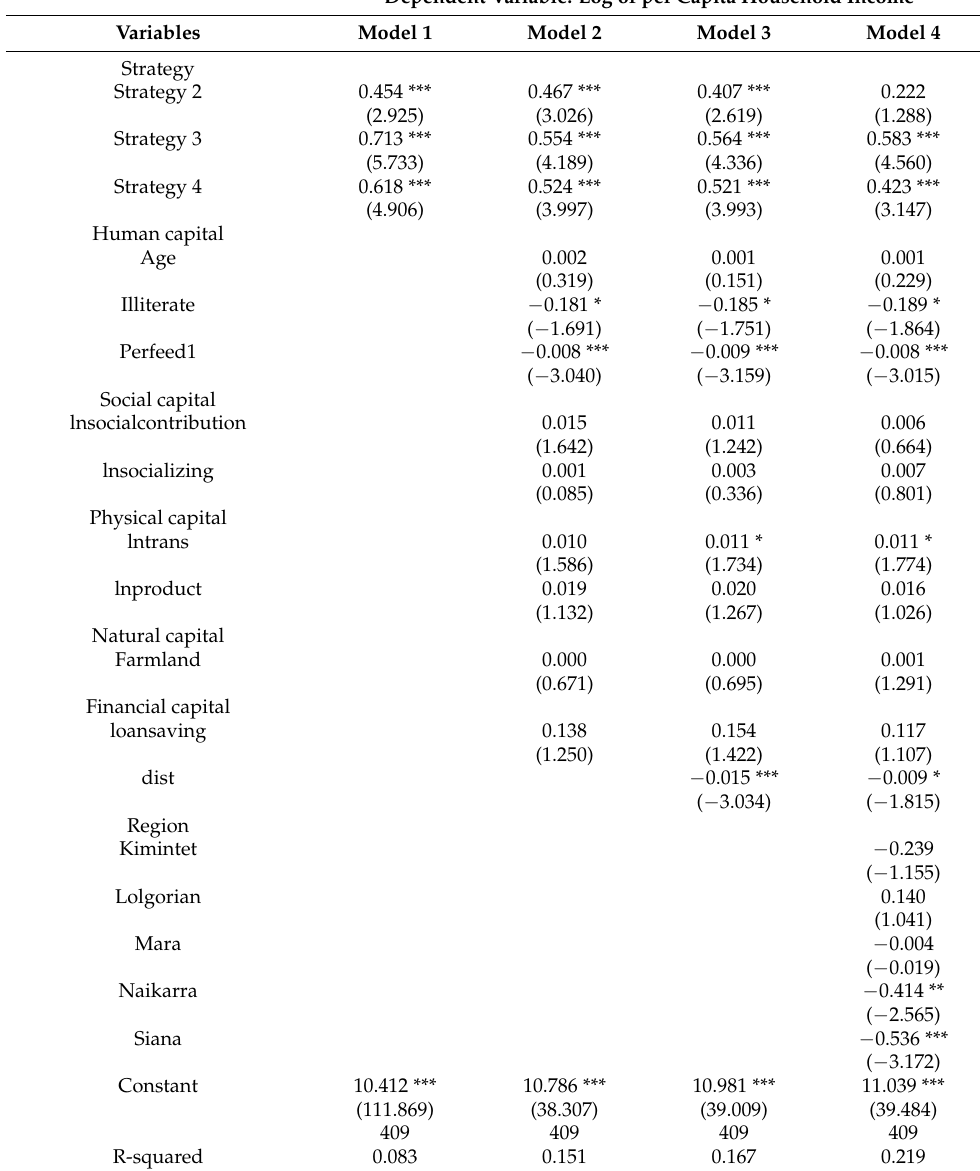
Table 5. The impact of different livelihood strategies on total household